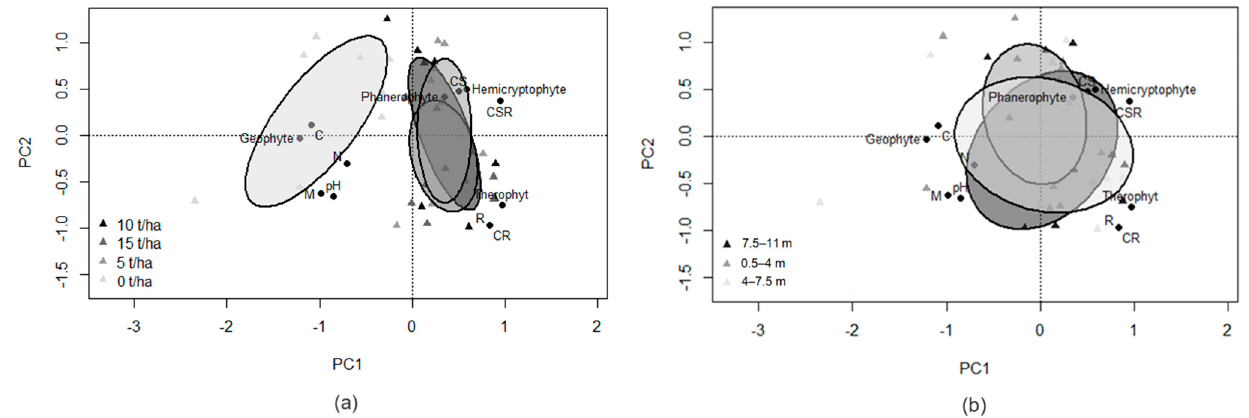
Figure 5. Principal Component Analysis of plant functional trait values that differ significantly: ( a ) between fertilised and non-fertilised plots; ( b ) depending on distance from the drainage ditch. Plant functional traits: Geophyte; Hemicryptophyte; Phanerophytes; Therophyte; C—competitors; S—stress tolerant; R—ruderal. Ellenberg’s indicator values: N—Nitrogen, M—Moisture. Cumulative % variance for PC1 and PC2 explain 90.4%.